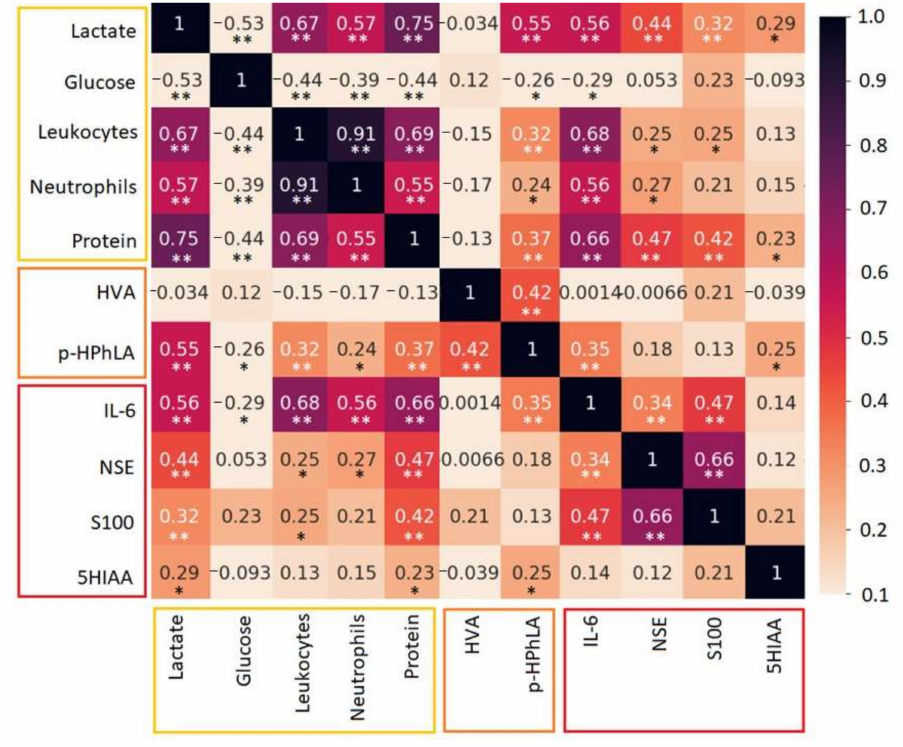
Figure 2. Spearman’s rank correlation coefficients for the different parameters in CSF: clinical and biochemical parameters (lactate, glucose, leukocytes, neutrophils, and protein), aromatic metabolites (HVA and p -HPhLA), and biomarkers (IL-6, NSE, S100, and 5HIAA). Negative correlations for glucose are not colored. * The correlation is significant at p = 0.05 (2-tailed); ** the correlation is significant at p = 0.01